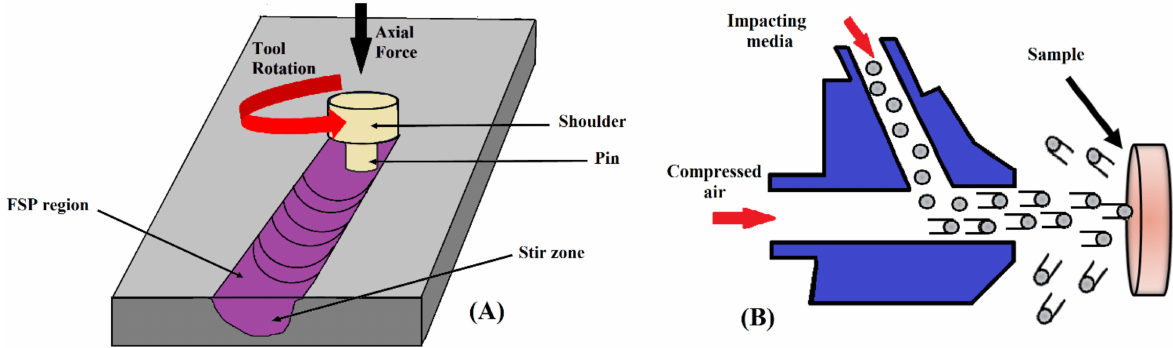
Figure 5. Schematic of the friction stir process ( A ) and severe shot peening ( B ); reproduced from [54], from Elsevier, 2020.